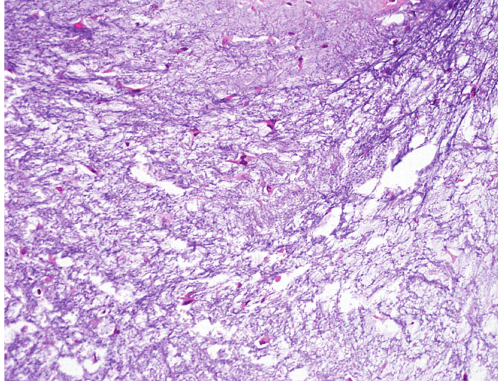
Figure 7: Extensive myxoid change in